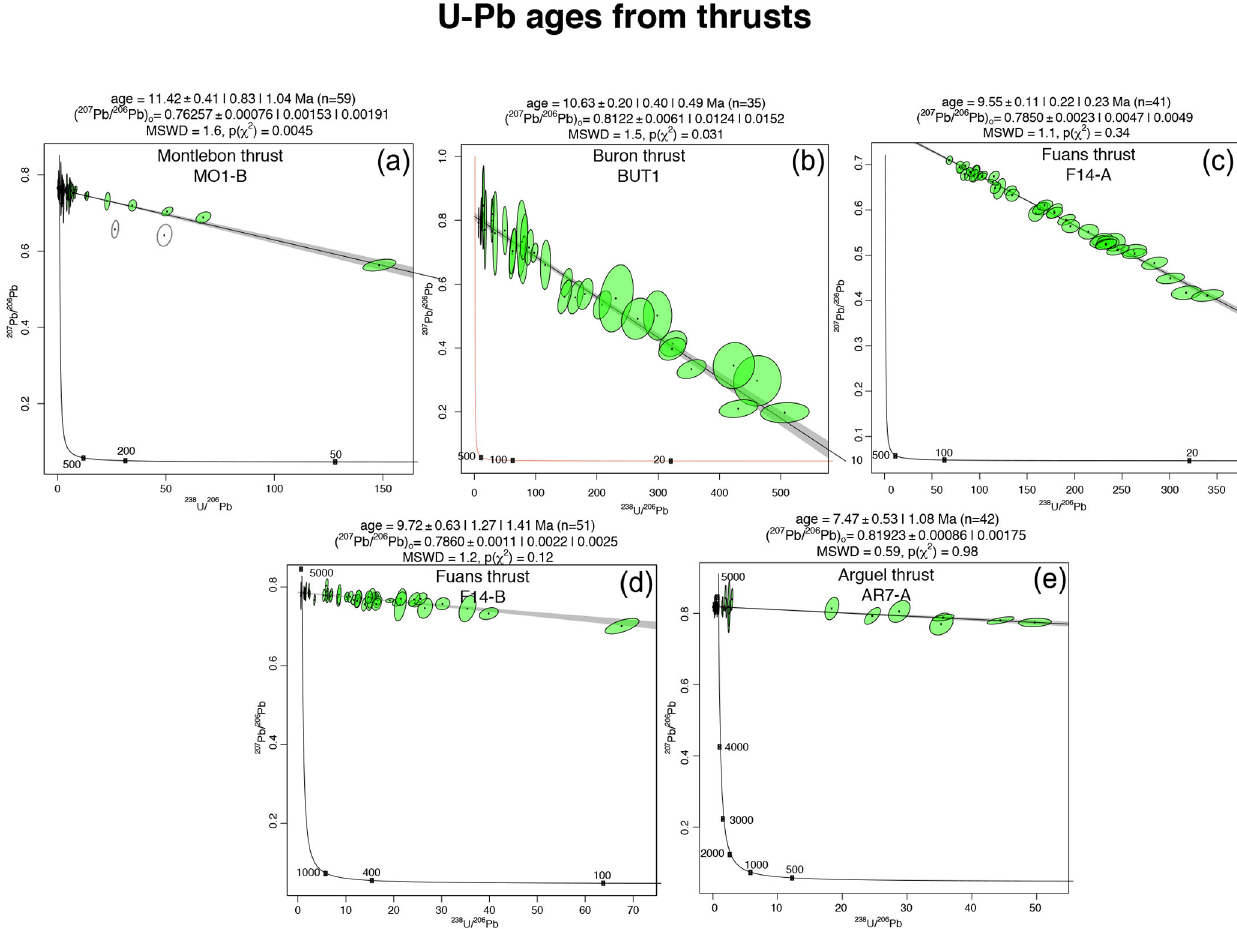
Figure 5. Tera–Wasserburg concordia diagrams of thrust faults. (a) Montlebon thrust. (b) Buron thrust. (c, d) Fuans thrust. (e) Arguel